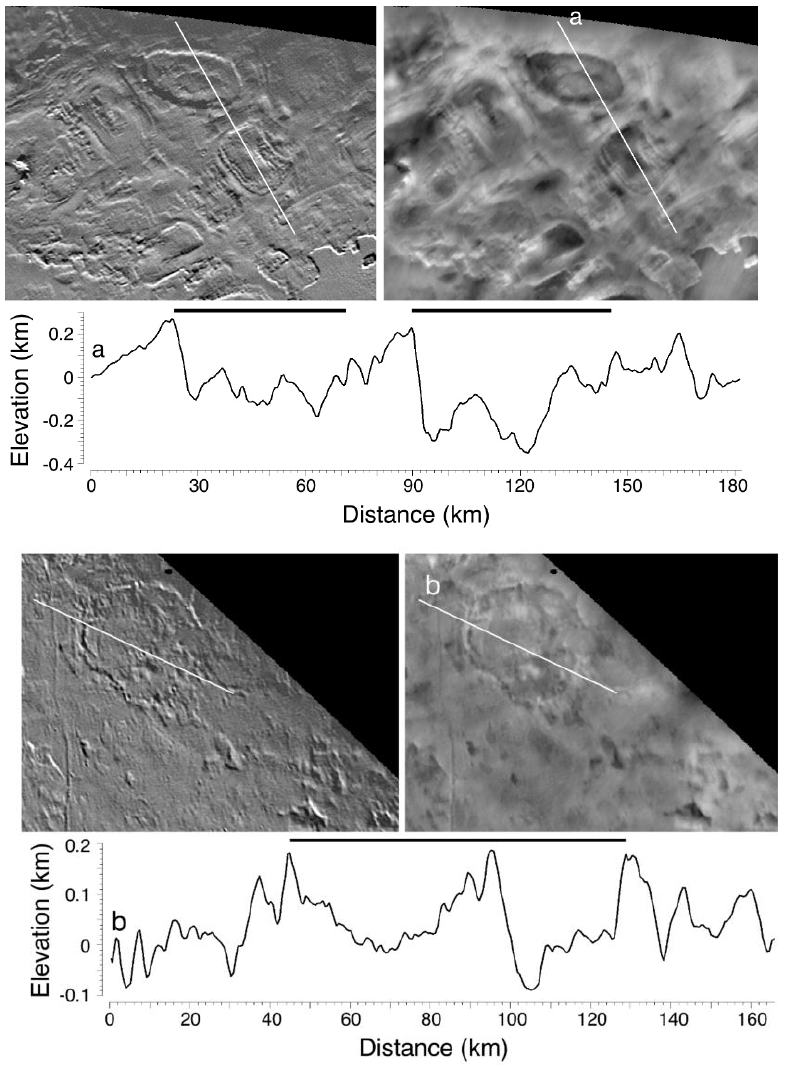
Figure 20. Topographic profiles of three paterae on Triton. ( Top ) Image mosaic and ( right ) DEM scene width ( a ) is ~220 km wide, northwest of Tuonela Planitia and centered at 40 ◦ N, 5 ◦ E. ( top ) Image mosaic and ( right ) DEM scene width ( b ) is ~275 km across and is centered at 14 ◦ N, 60 ◦ E, from SG-PC-DEM in Figure